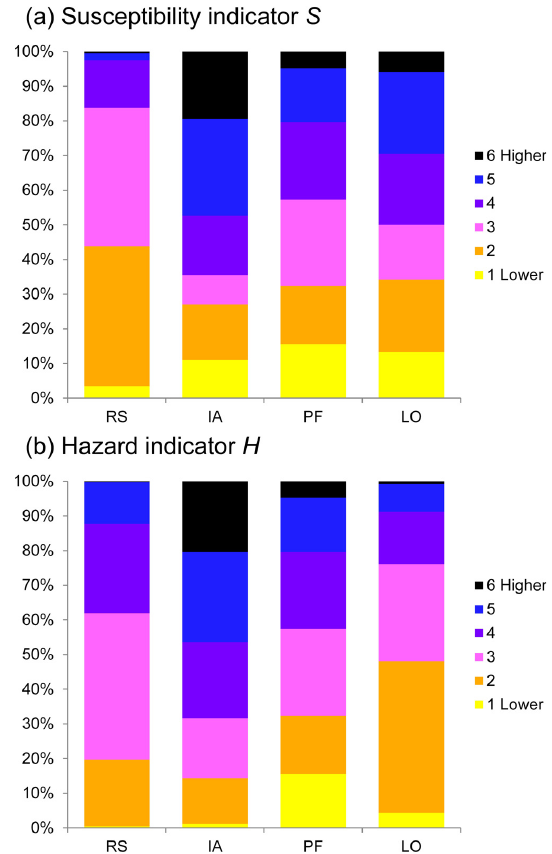
Fig. 7. Relative abundance of (a) the susceptibility and (b) the haz- ard indicator classes for the four considered processes. The indi- cators for rock slides (RS), ice avalanches (IA) and periglacial de- bris flows (PF) relate to raster cells, the indicators for lake outburst floods (LO) to lakes. Only those raster cells or lakes with an indica- tor of at least 1 are